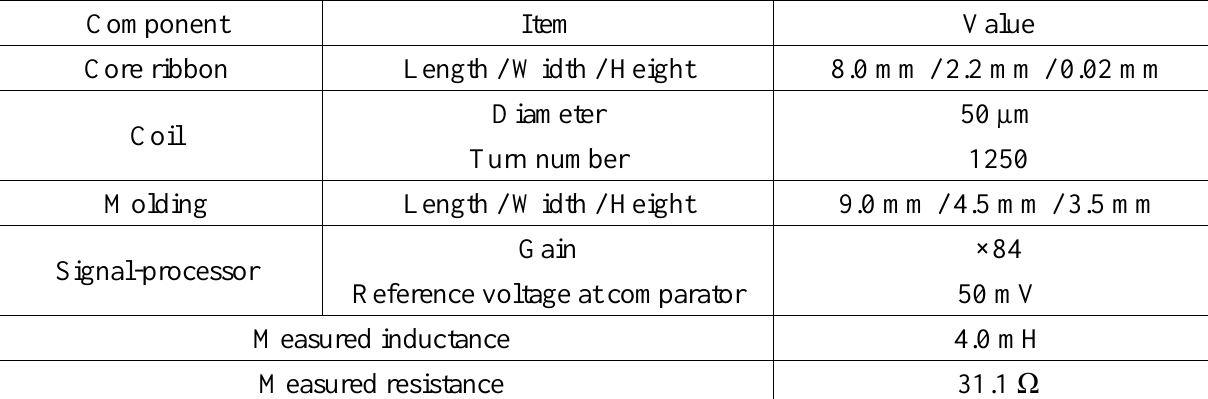
Table 2. Fabricated dimensions of MMIS.